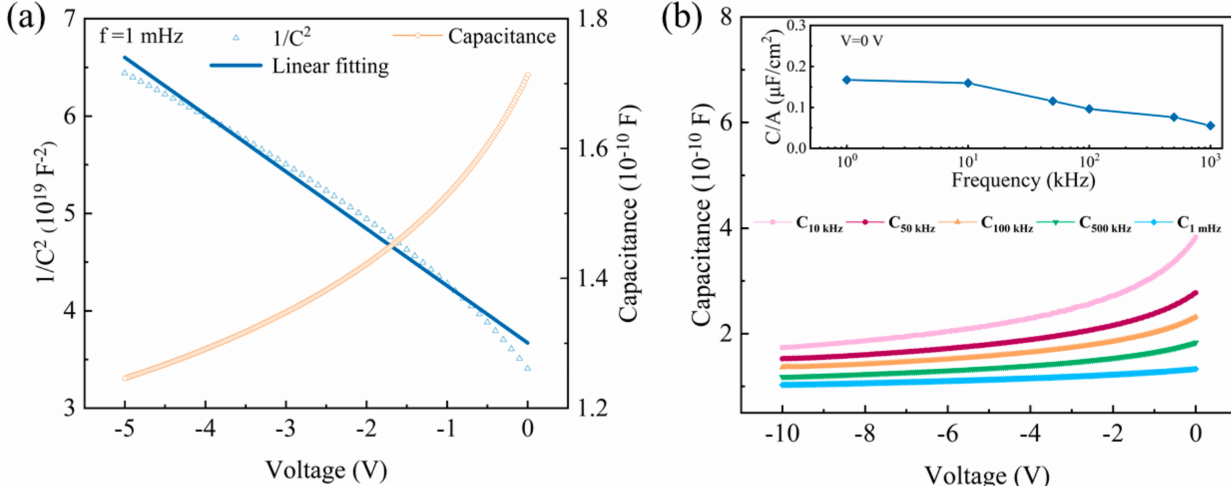
Figure 6. ( a ) The C–V and 1 -V curves, ( b ) the C–V curves with different C 2